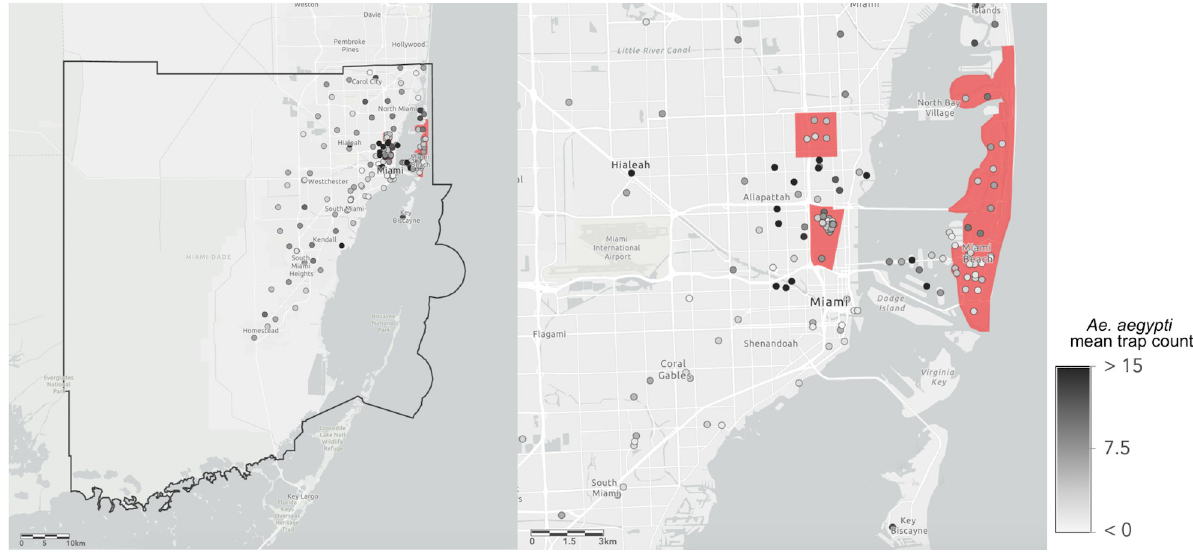
Fig 1. Map of Miami-Dade county mosquito control traps. The map on the left includes all 172 traps from which data was collected for this study. The black bold line represents the boundary of Miami-Dade County. The map on the right highlights areas (shaded red) that sustained local Zika virus transmission during the 2016 outbreak. Trap locations are shaded according to the mean value of Ae . aegypti collected by that trap over each collection during the study period